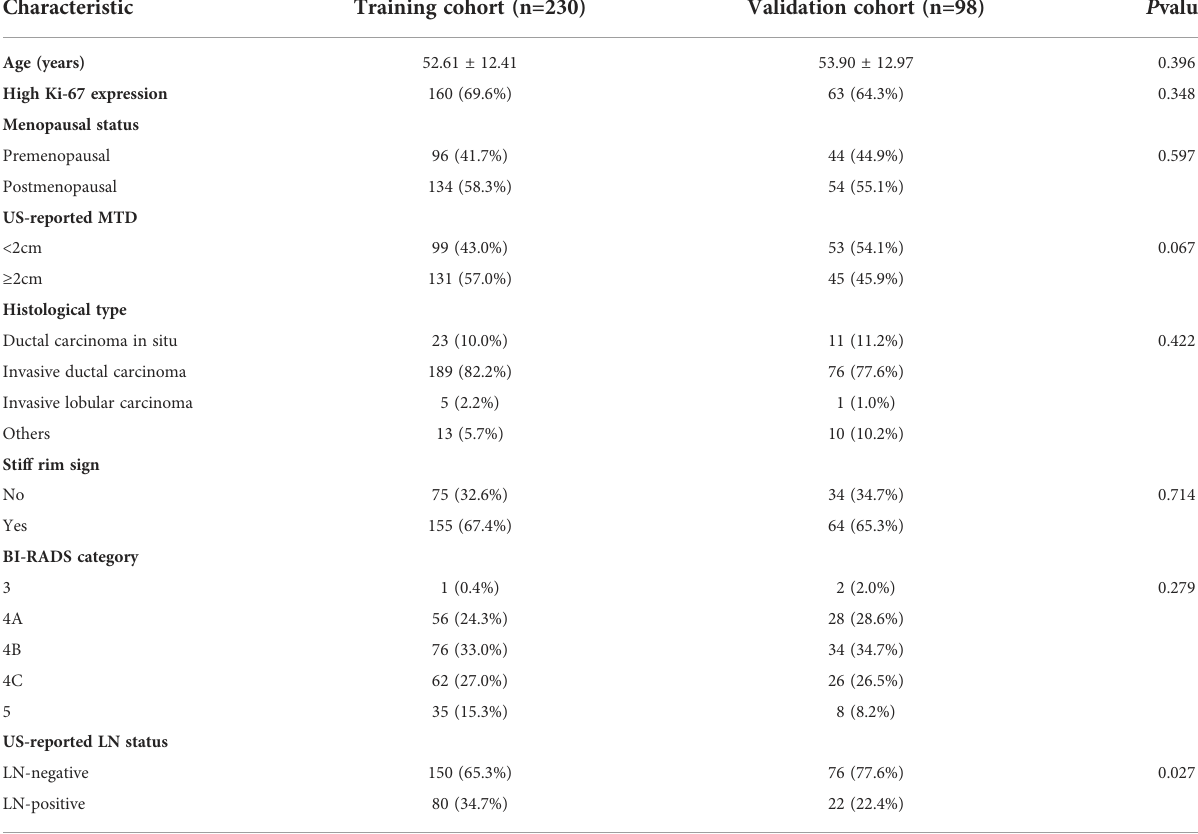
TABLE 1 Comparison of descriptive characteristics of the training and validation cohorts.